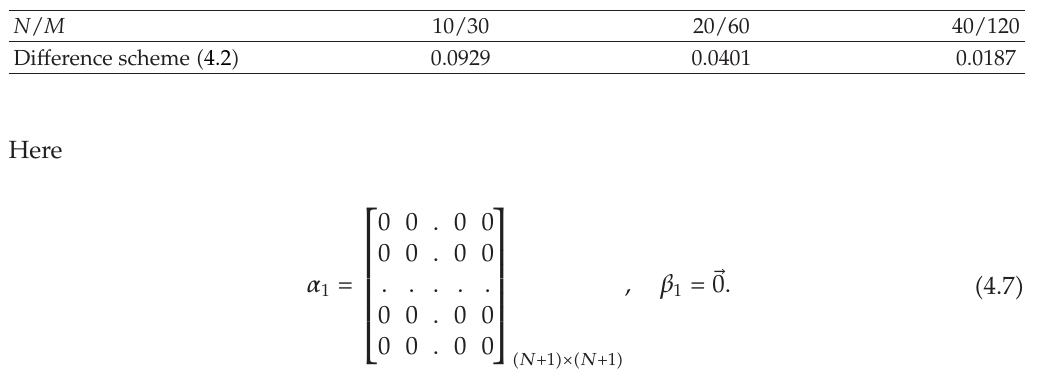
Table 1: Error analysis.